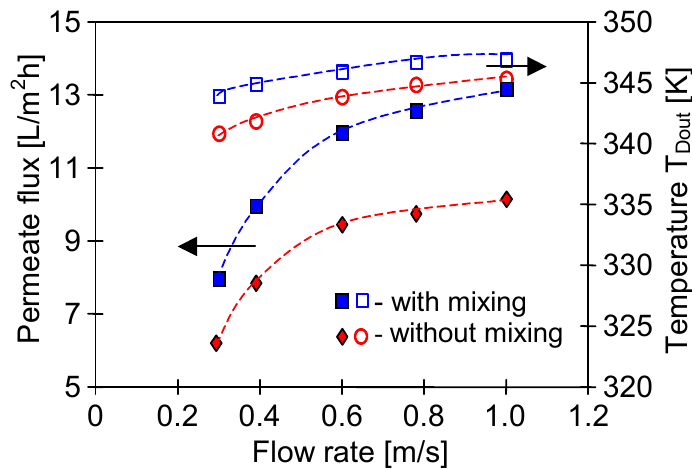
Figure 11. The influence of distillate flow rate and turbulence in the feed tank on the permeate flux and distillate outlet temperature in the presence and absence of feed mixing. Mode 1: T F = 353 K. Module SMD4 (PV370, L = 120 cm).